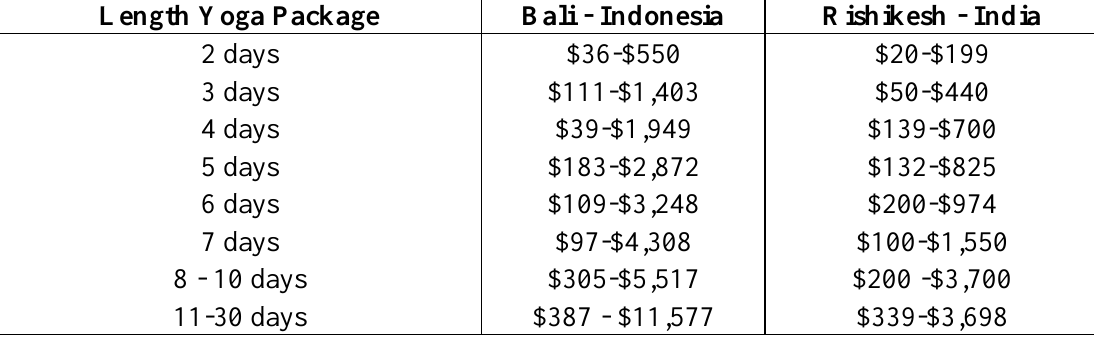
Table 1. Comparison Yoga Package Retreat Offered in Bali and India Length Yoga